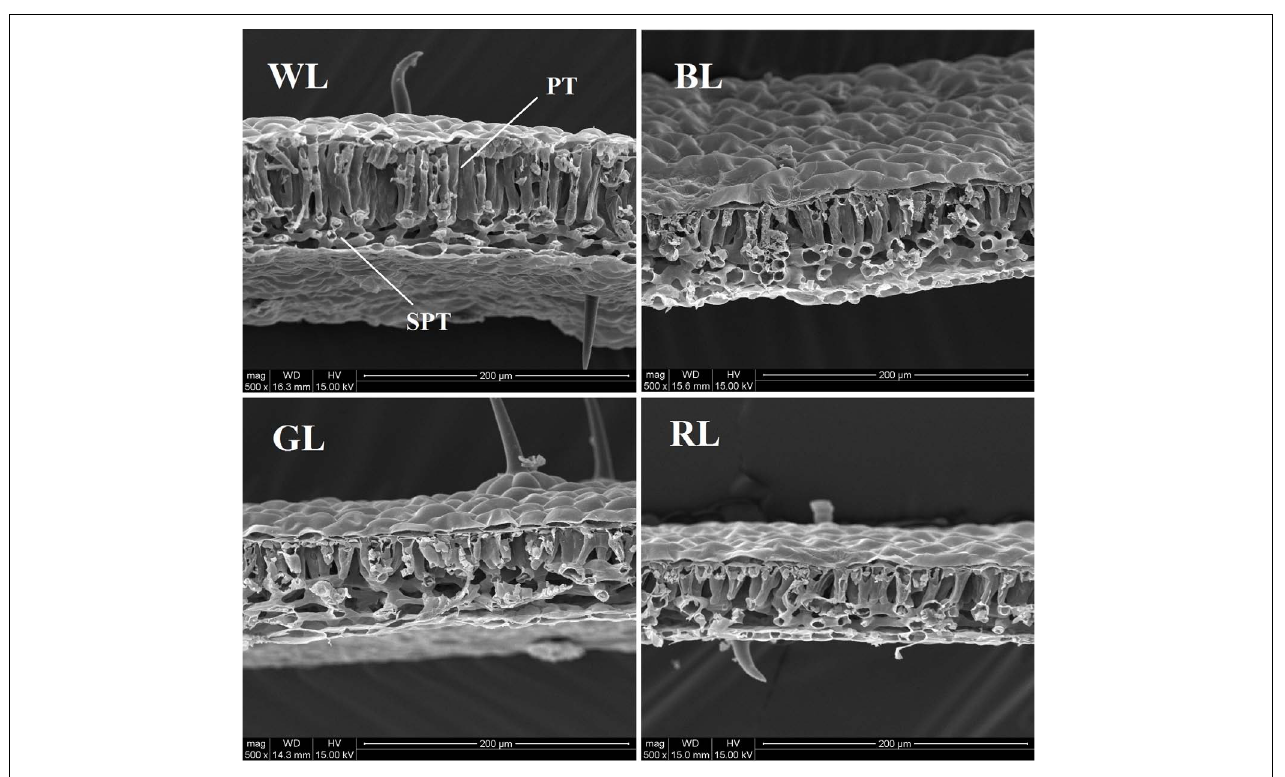
FIGURE 2 | Anatomical structure of C. paliurus leaves under different light treatments (PT, palisade parenchyma; SPT, spongy tissue). Scale: 200 µ m. LED lamps used: WL, white light; BL, blue light; GL, green light; RL, red